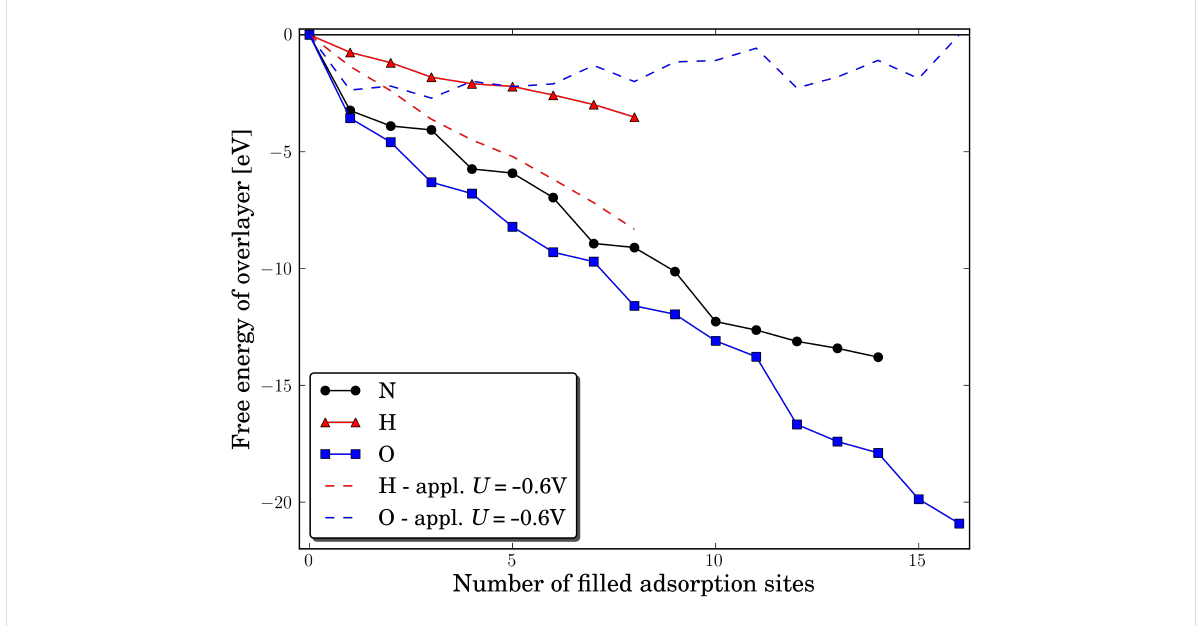
Figure 2: The total free energy for covering the Mo 13 nanocluster with nitrogen, oxygen or hydrogen. The filled black line shows the filling of the nitrogen skin, while the filled blue line shows the evolution of oxygen coverage at neutral bias. The red coloured line shows the adsorption of hydrogen, while the dashed red coloured line shows adsorption of hydrogen and the dashed blue line shows the adsorption of oxygen at an external applied potential of − 0.6 V, which is the potential needed for electrochemically ammonia production previously determined for the clean and nitrogen covered molybdenum nanocluster